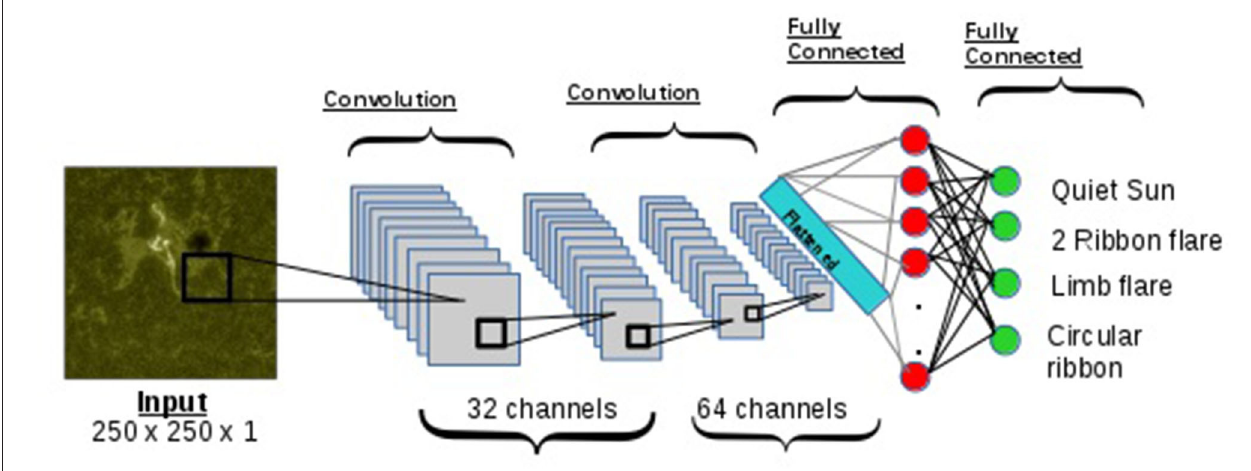
TABLE 1 | Details pf each CNN layer with the number of filters, size of kernels, and activation functions used shown. Layer Number of nodes Kernel size (weights) Stride Activation function Convolution 32 3 × 3 1 ReLU Max Pooling / 2 × 2 / Convolution 64 3 × 3 Max Pooling / 128 61 ∗ 61 ∗ 64 × 128